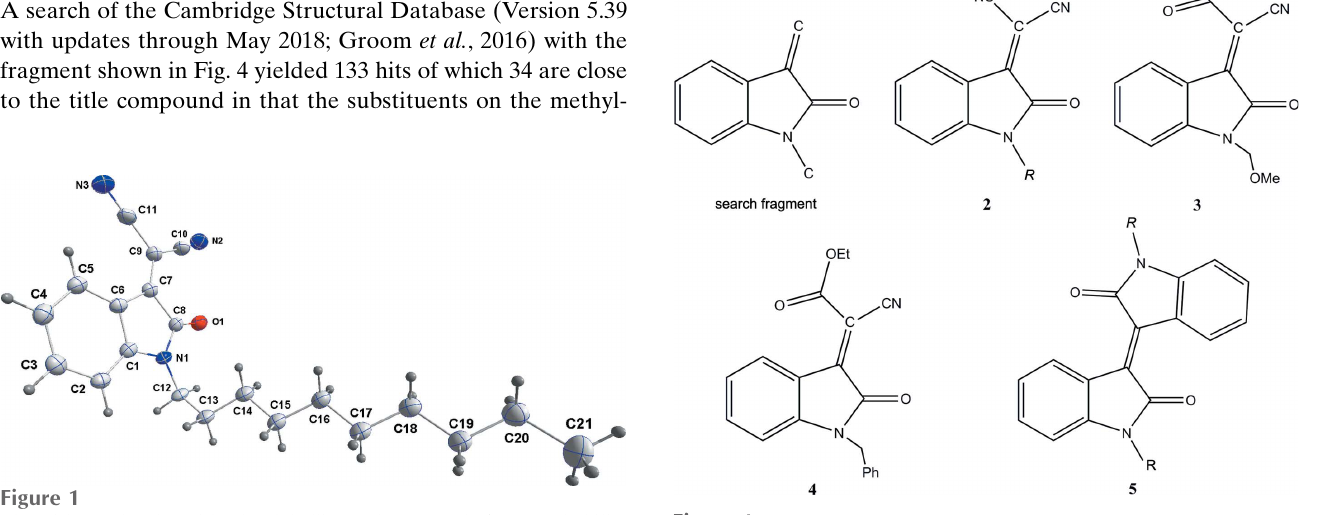
Figure 4 Search fragment and related